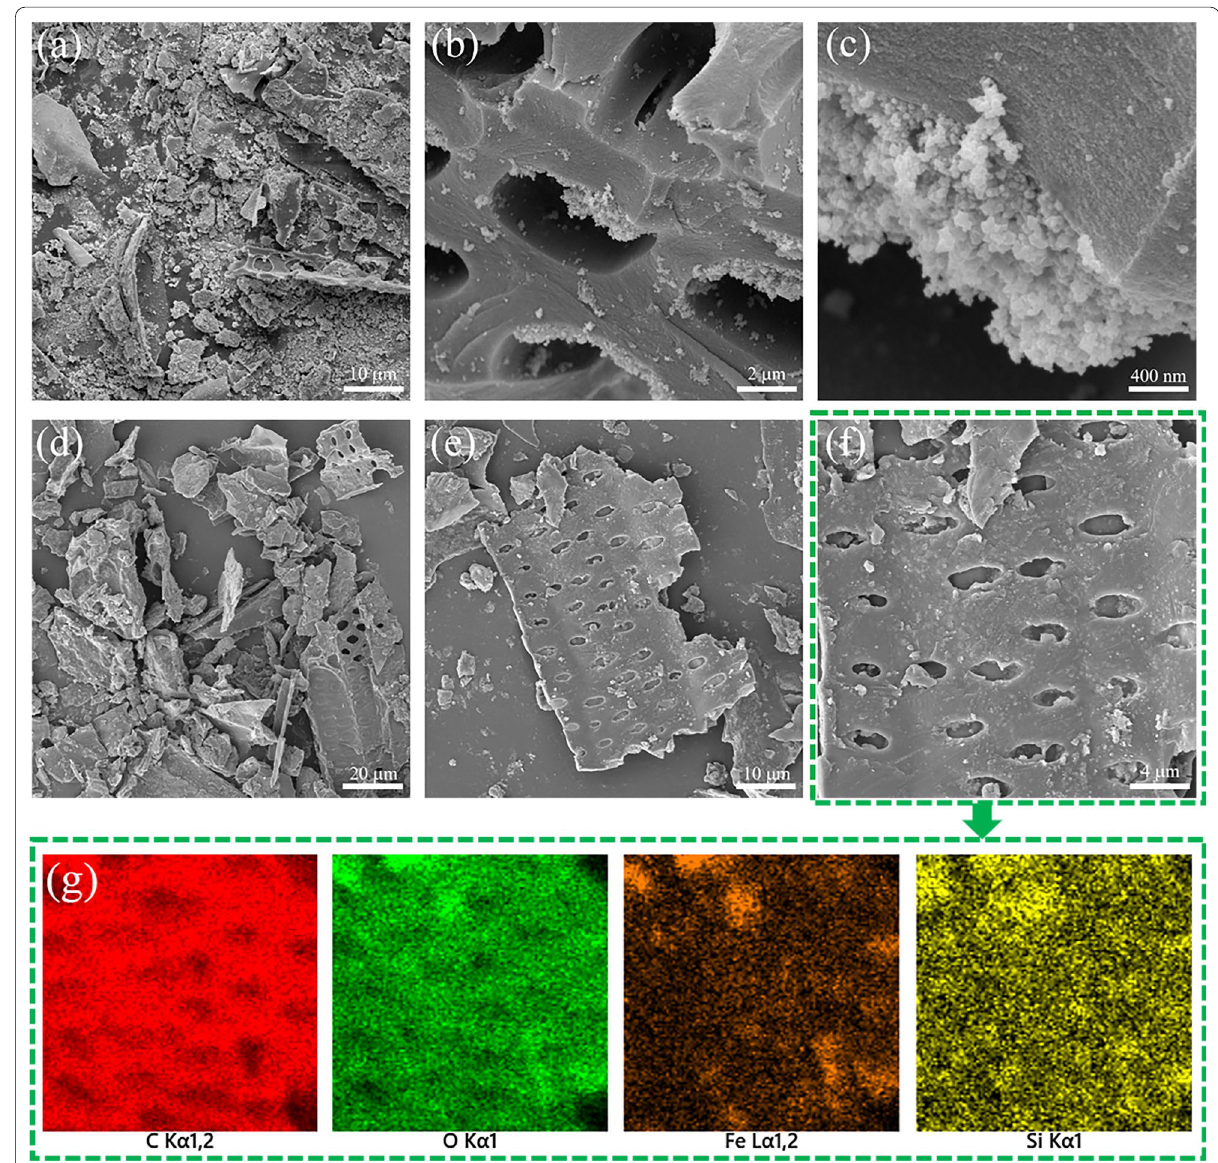
Fig. 3 SEM micrographs of MBC ( a – c ) and OMBC ( d – f ). A selected area on the OMBC for EDS measurement ( f ). Elemental mapping images of OMBC for C, O, Fe, and Si ( g )